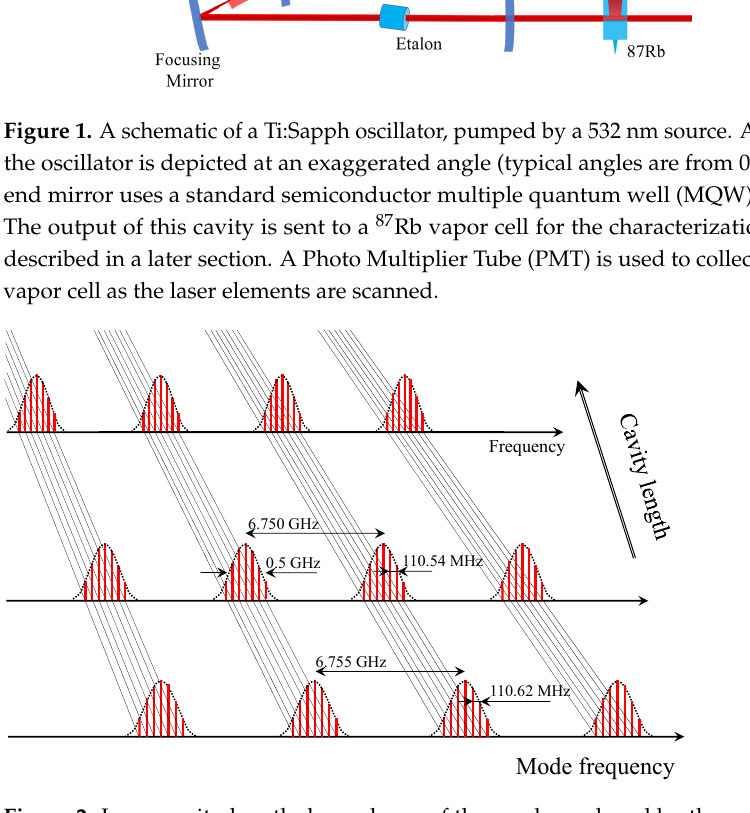
Figure 2. Laser cavity length dependence of the comb produced by the nested design depicted in Figure 1. For a particular cavity length (of the order of 2.71 m), laser cavity modes with a spacing of 110.62 MHz are identified (bottom of the figure). This structure repeats periodically every 6.755 GHz, a frequency that is sightly smaller than the etalon mode spacing of 6.821 GHz, since the etalon is 15.12 cm long with an index of 1.4534 at 20C. As the laser cavity length is increased, all mode spacings shrink in the same